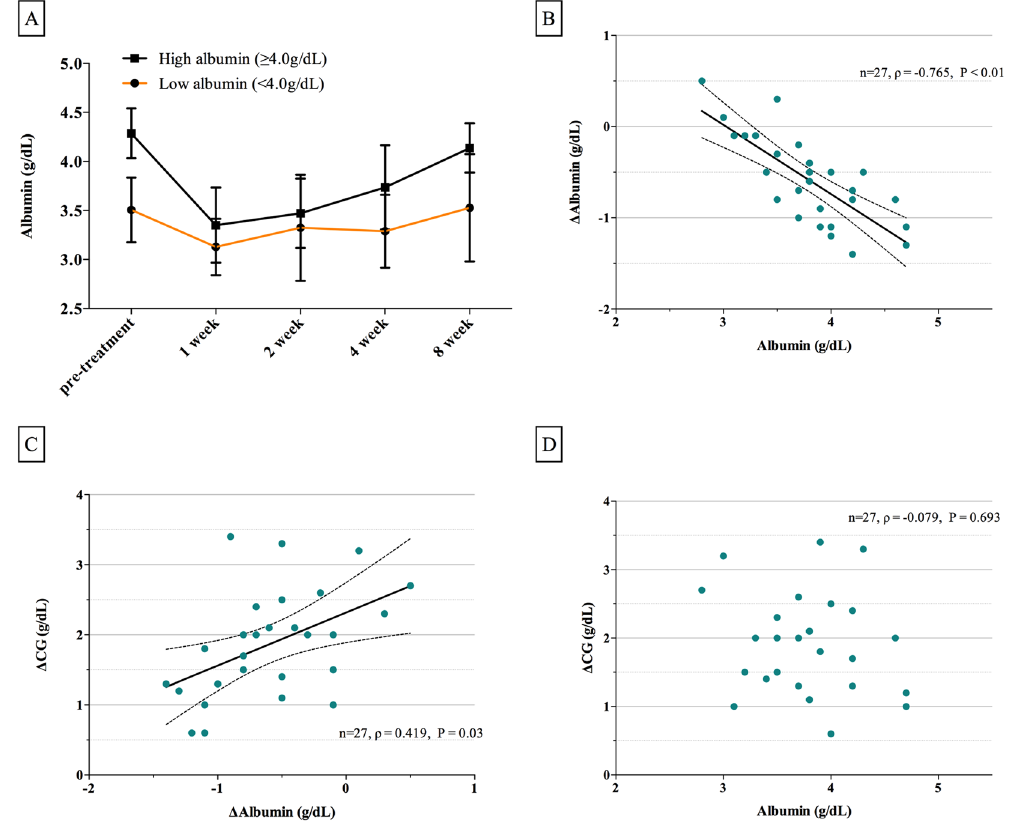
Figure 2. The association between albumin and calculated globulin (CG) in patients with autoimmune encephalitis. ( A ) Serial changes in serum albumin before and over four time points (the first, second, fourth, and eighth weeks) after IVIg. Serum albumin changed less after IVIg in patients with low albumin ( < 4.0 g/dL) than patients with high albumin ( ≥ 4.0 g/dL). Dots indicate medians, and vertical bars indicate interquartile range. ( B ) Scatterplot displaying the correlation between albumin and Δ Albumin (pretreatment albumin - albumin at the first week after IVIg). ( C ) Scatterplot displaying the correlation between Δ Albumin and Δ CG (CG at the first week after IVIg - pretreatment CG) ( D ) Scatterplot displaying the correlation between albumin and Δ